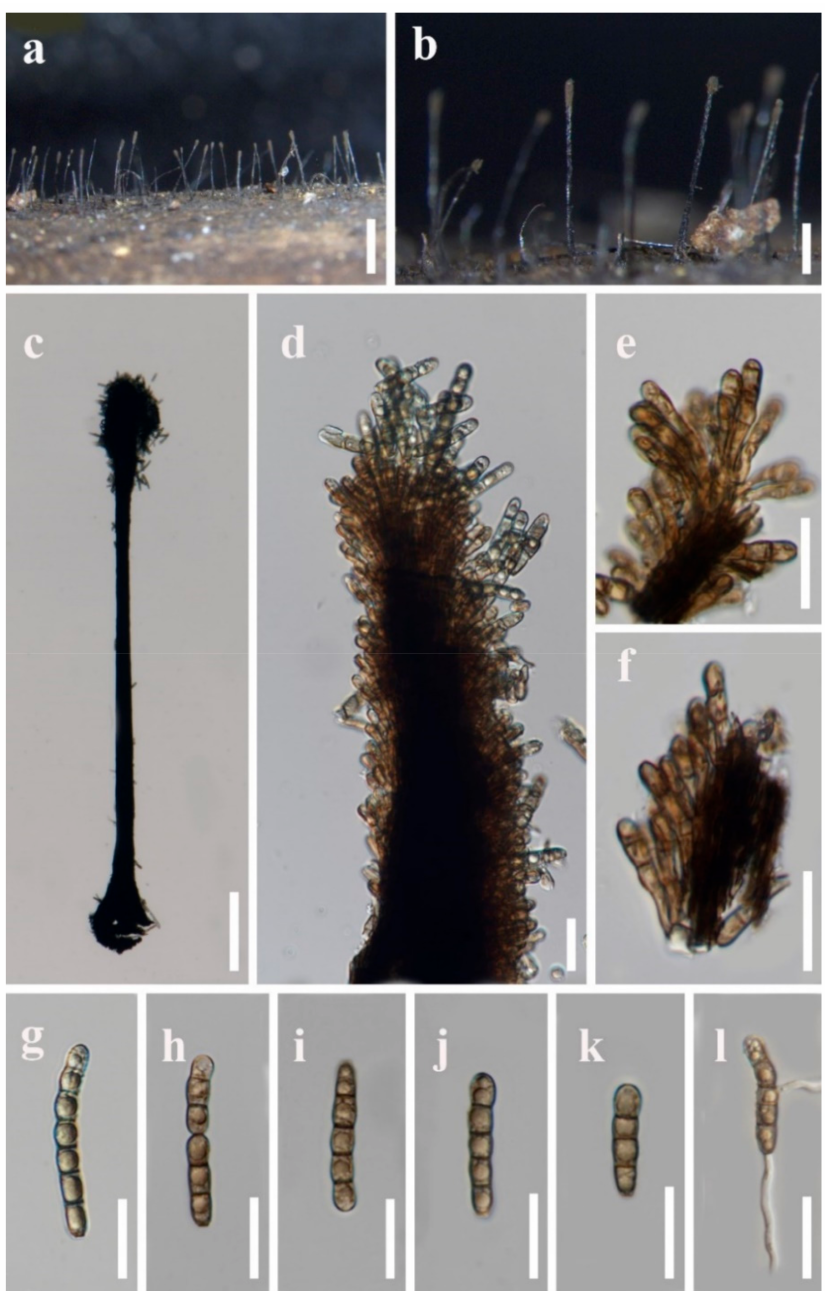
Figure 3. Vamsapriya indica (MFLU 21-0088) ( a , b ) Colonies on natural substrate. ( c ) Conidiophore and conidia. ( d – f ) Conidiogenous cells and developing conidia. ( g – k ) Conidia. ( l ) Germinated conidium. Scale bars: a = 2000 µ m, b = 1000 µ m, c = 200 µ m, d – l = 20 µ